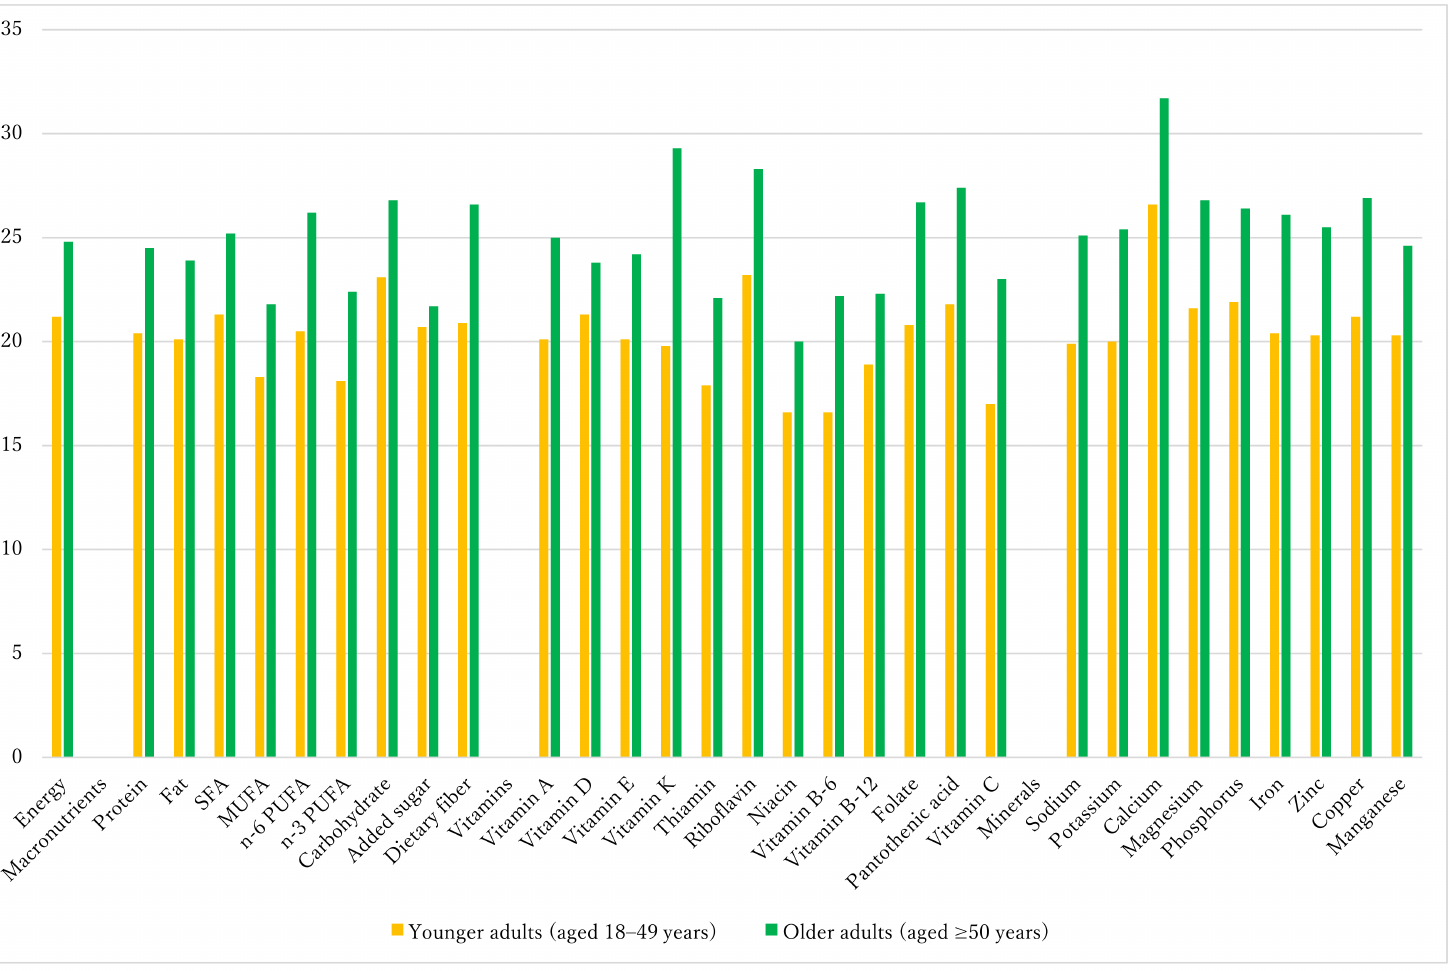
Figure 2. Percentage contribution of breakfast to daily intakes of energy, macronutrients, vitamins, and minerals in younger adults (aged 18–49 years; n = 6028) and older adults (aged ≥ 50 year; n = 13,135). Values are